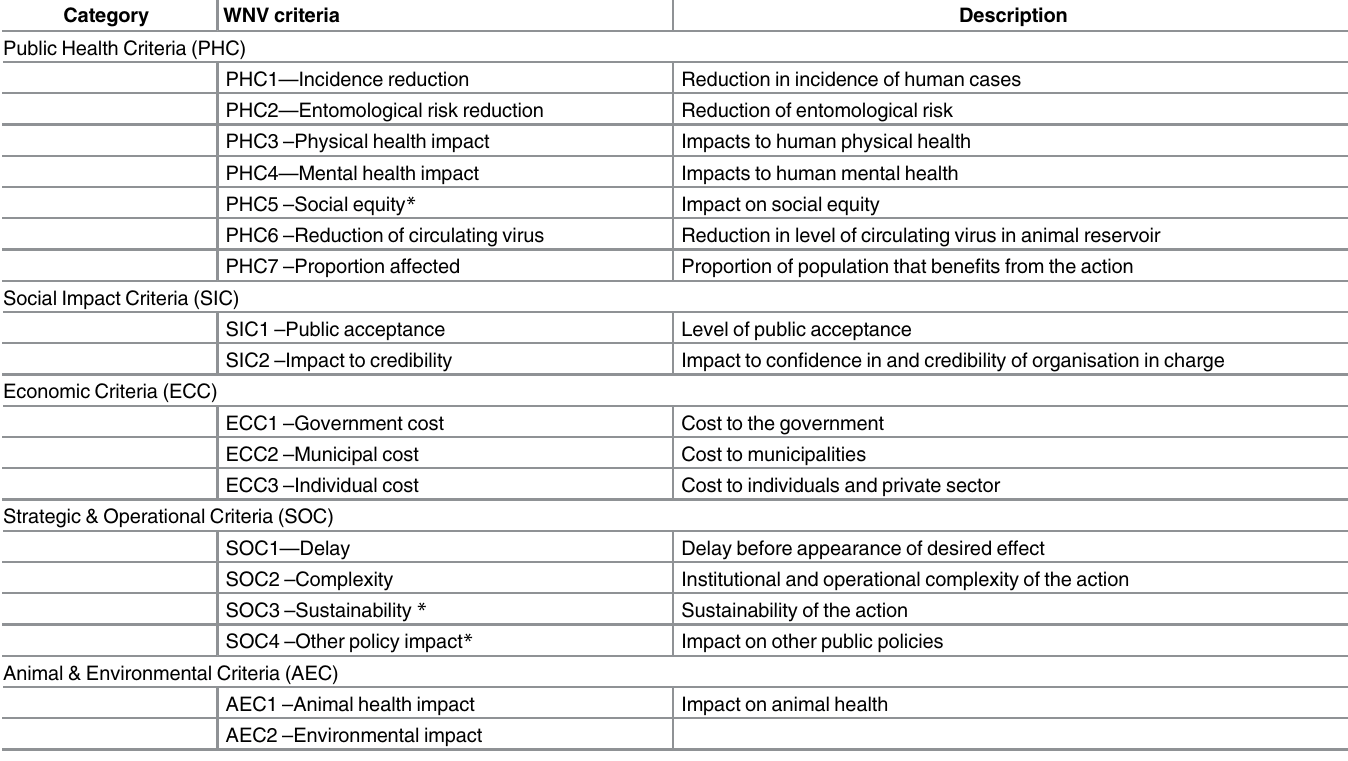
Table 3. Criteria for the management of West Nile virus in Quebec.